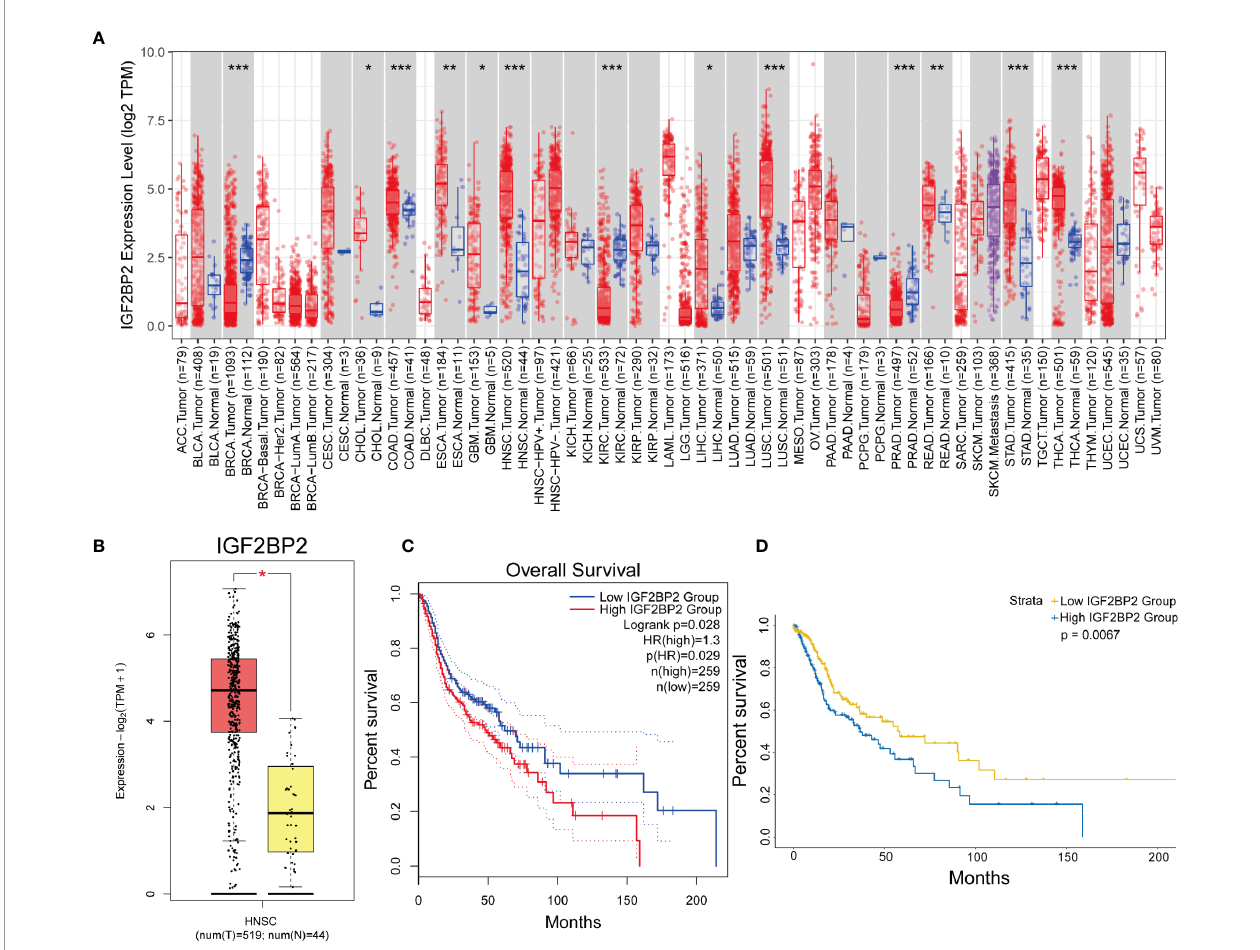
FIGURE 3 | The expression and prognostic value of IGF2BP2 in HNSCC. (A) The expression of the IGF2BP2 gene in pan-cancer was analyzed with TIMER. (*p < 0.05, **p < 0.01, ***p < 0.001). (B, C) The expression and prognostic value of the IGF2BP2 gene in HNSCC was analyzed with GEPIA2. (HR, hazard ratio) (D) Kaplan – Meier survival curves illustrate the difference in OS based on the expression level of